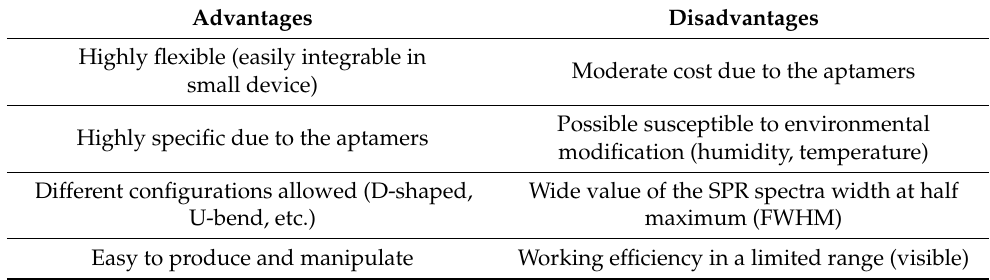
Table 3. Advantages and disadvantages of Apta-POF-SPR